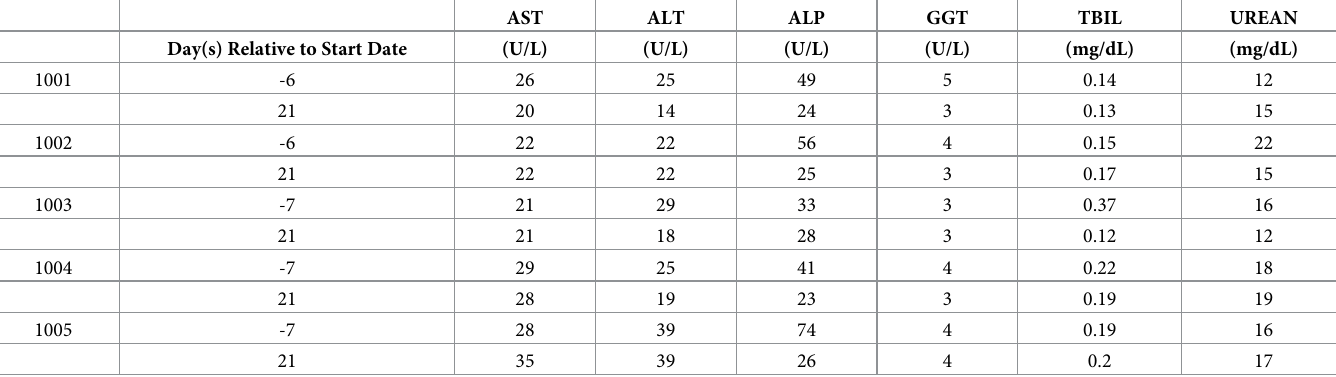
Table 4. Biochemistry reporting for each animal for AST, ALT, ALP, GGT, TBIL, and UREAN. AST ALT ALP GGT TBIL UREAN